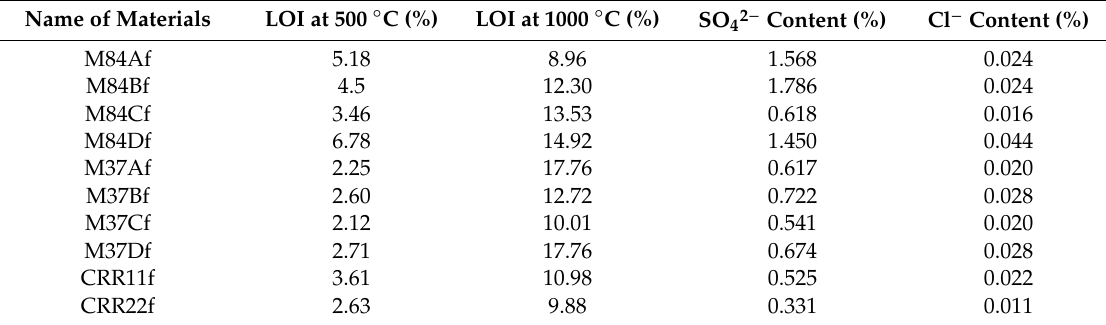
Table 7. Chemical properties of di ff erent